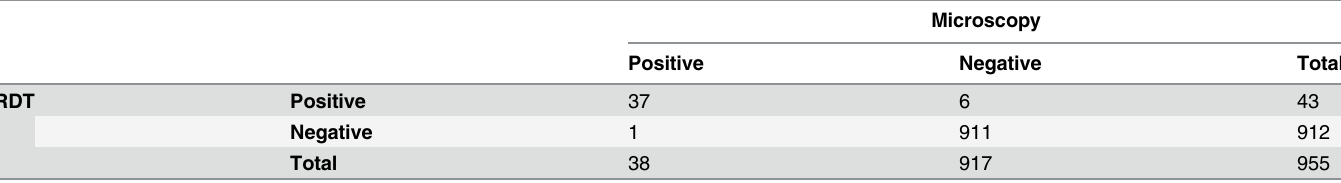
Table 4. RDT and microscopy results for P . vivax